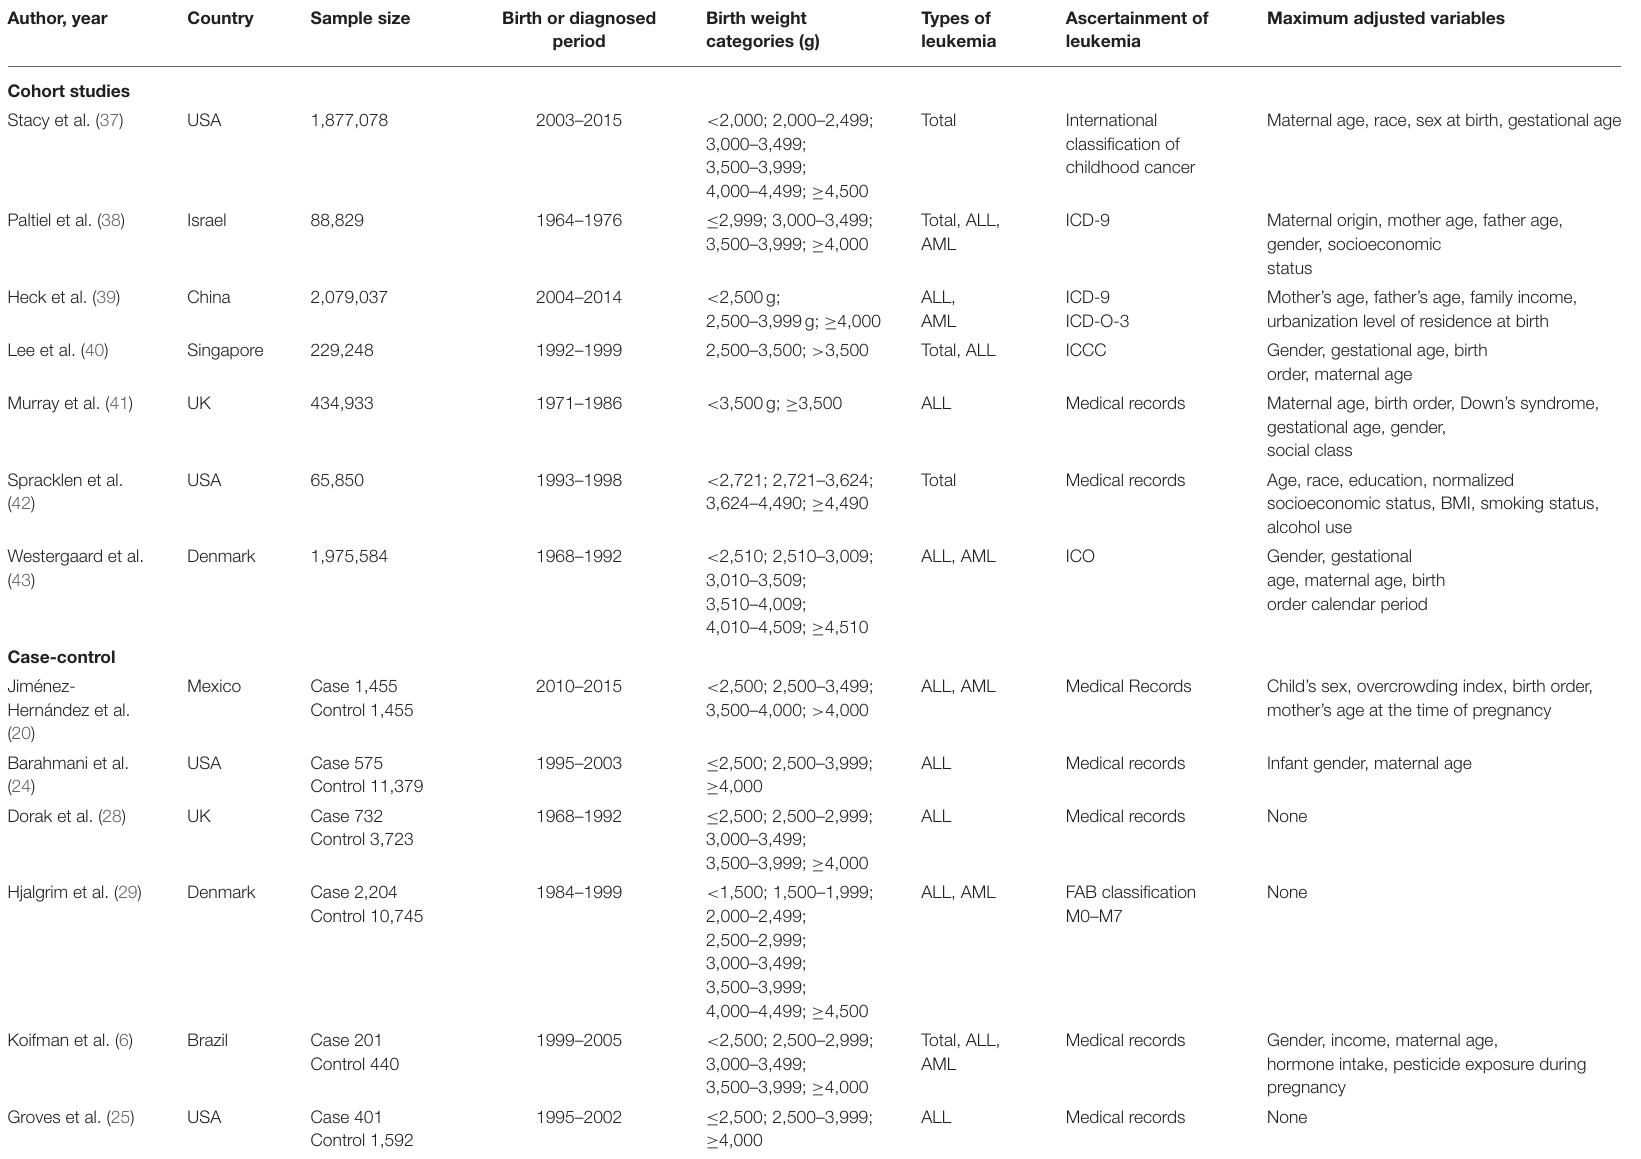
TABLE 1 | The detailed baseline information of 28 observational